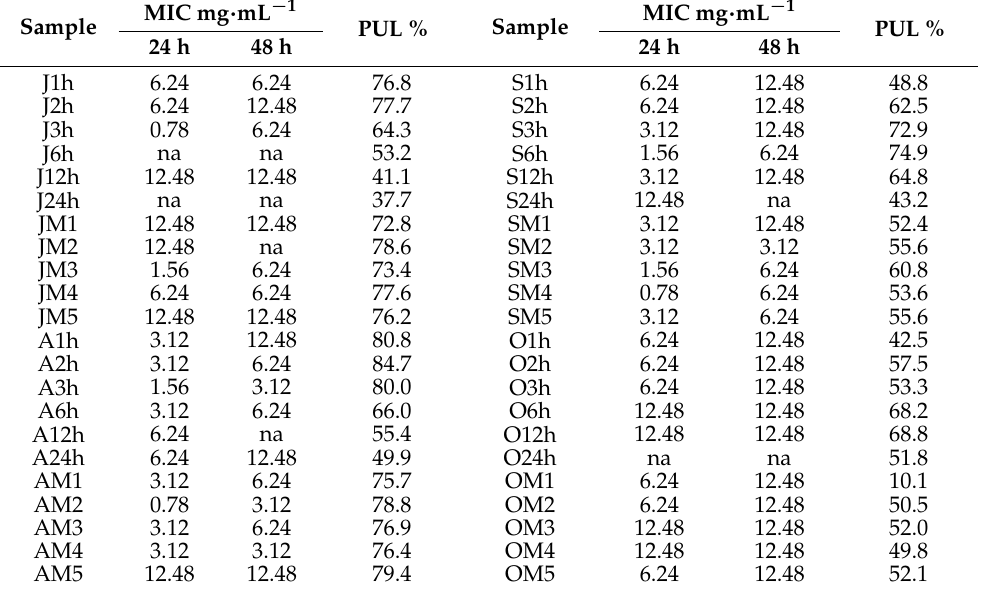
Table 6. Anti- Candida albicans activities of the 44 TEOCG samples. The antibacterial tests were carried out three times, and the average values were taken as the